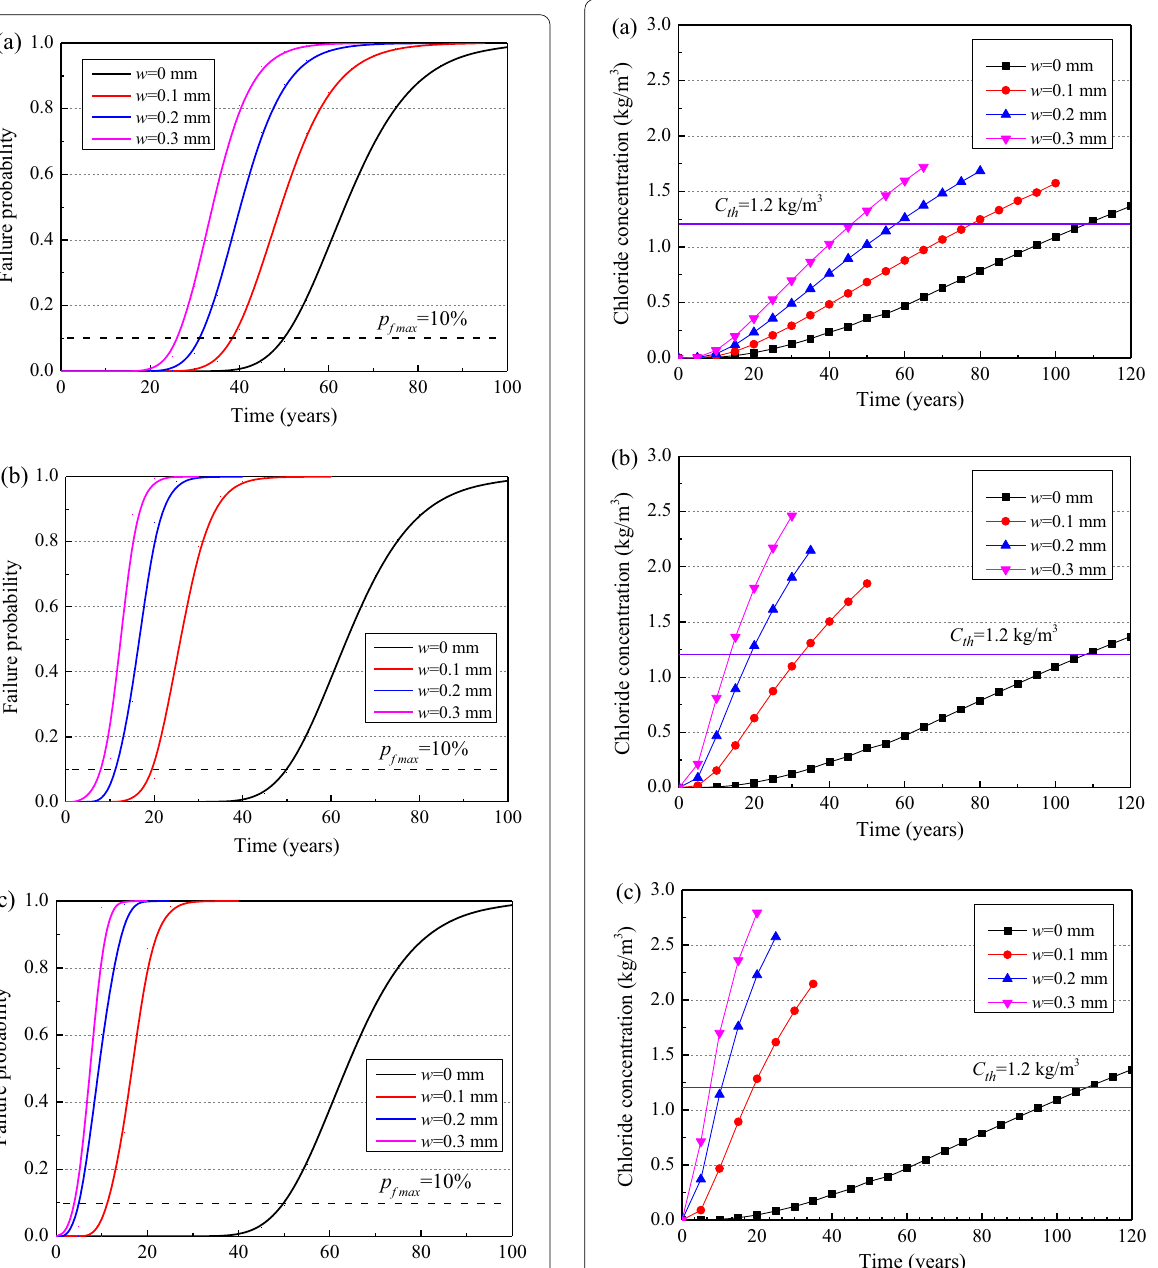
1, b n 5 and c n 10. = = =